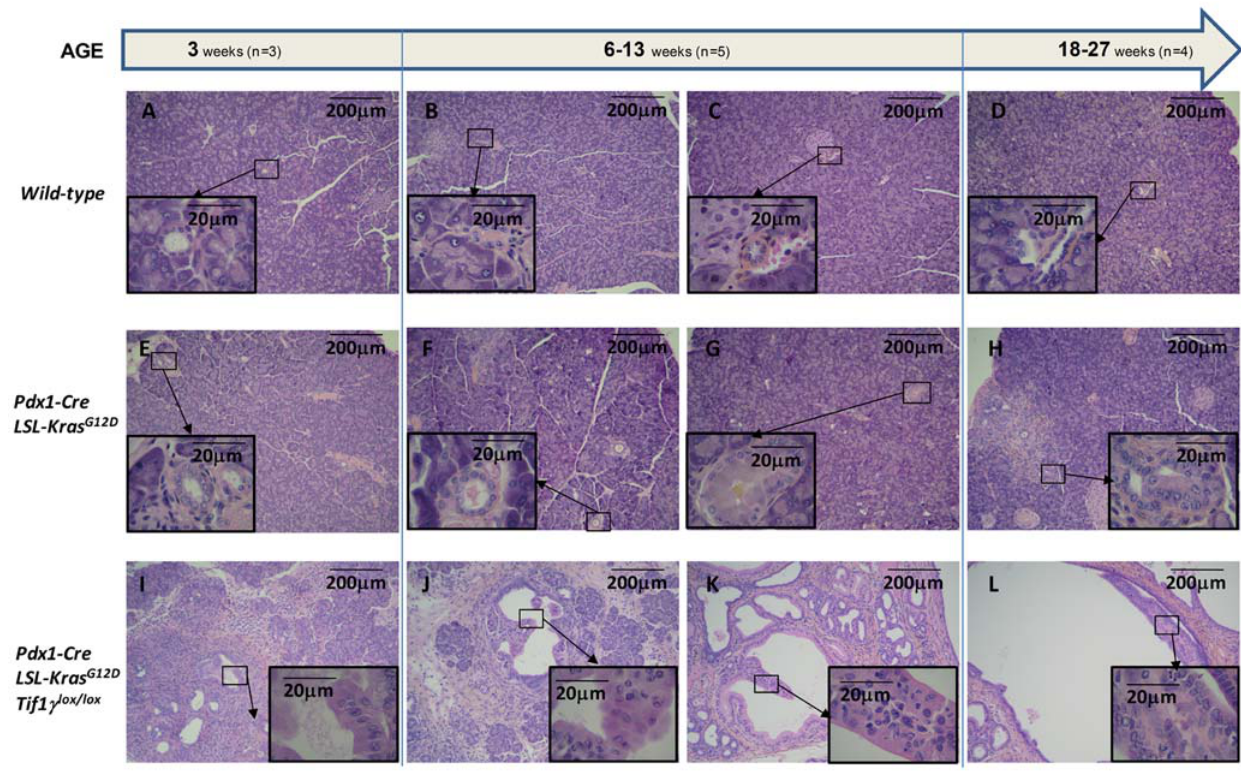
Figure 2. Inactivation of Tif1 c accelerates activated Kras G12D –mediated pancreatic neoplasia. Sections of wild-type (A–D), Pdx1-Cre;LSL- Kras G12D (E–H) and Pdx1-Cre;LSL-Kras G12D ;Tif1 c lox/lox (I–L) pancreas from mice at different ages were stained with HPS. Number of mice: 3 weeks, n=3; 6–13 weeks, n=5; 18–27 weeks, n=4. Inset pictures: Higher magnification.